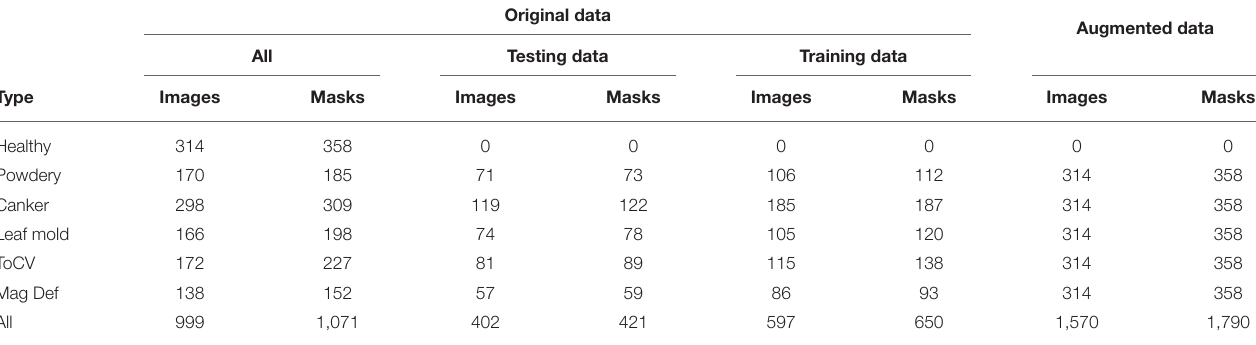
TABLE 1 | Dataset used in the experiment.